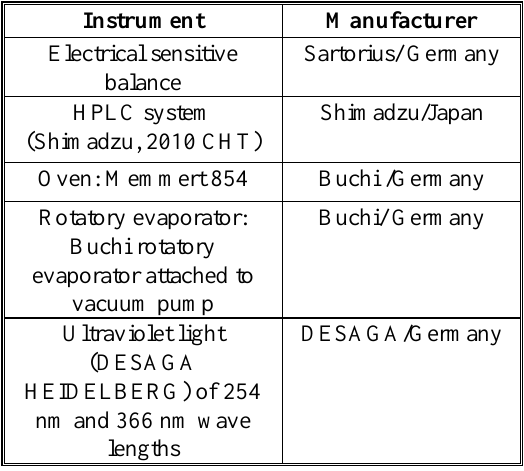
Table 2. Instruments used and their